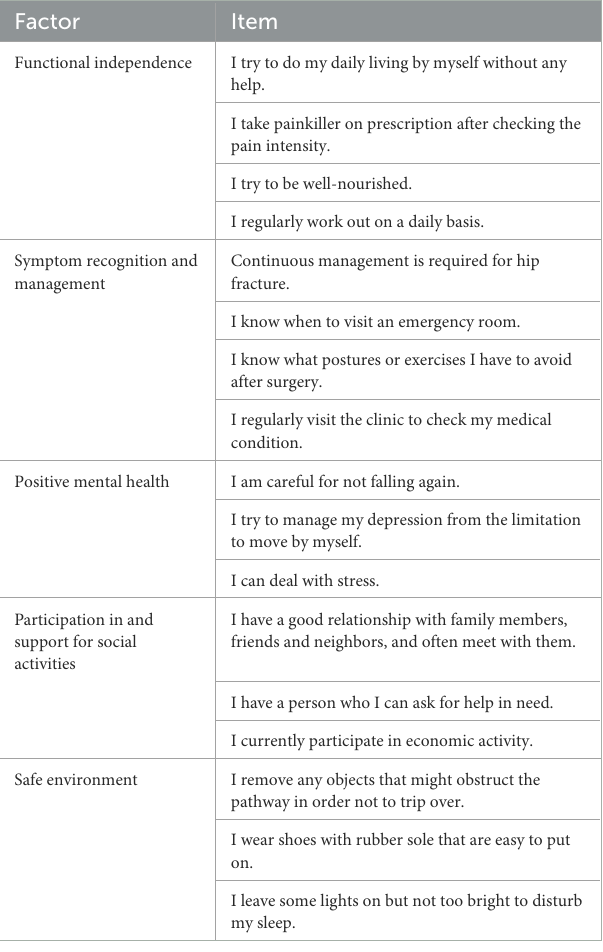
TABLE 4 The self-care scale for older adults undergoing hip fracture surgery. Factor Item Functional